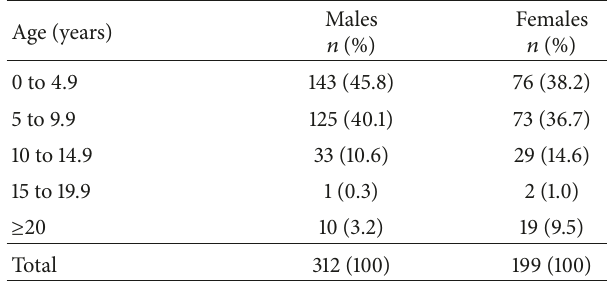
Table 1: Description of the study population by age and